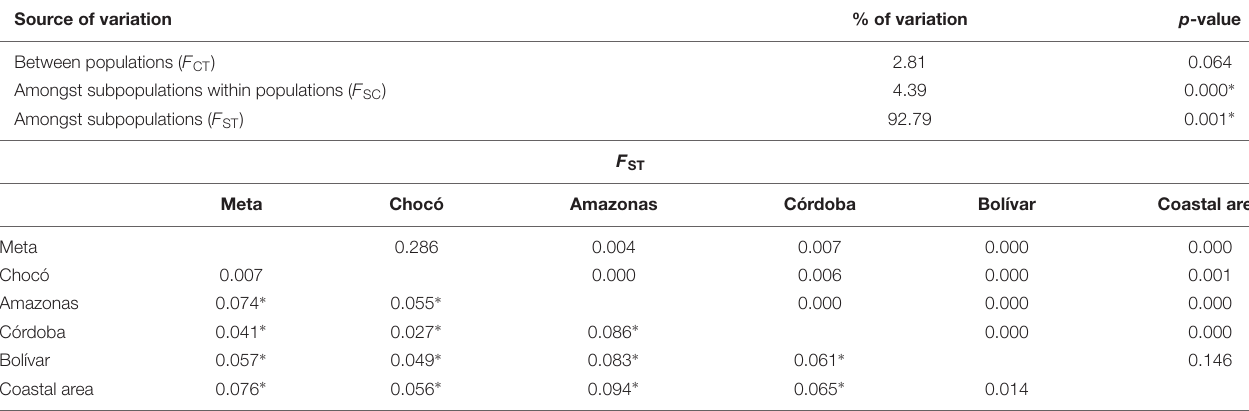
( Figure 4B ). Once the PvRBSA functional region’s